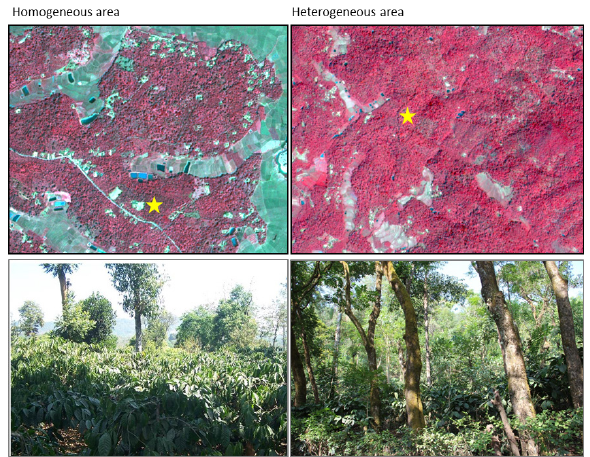
Figure-1. Spectral signature of coffee plantations in homogeneous and heterogeneous situations For object based classification, LISS-IV and Cartosat-1 data along with NDVI was used as source data for multiresolution segmentation. Optimizing the segmentation parameters